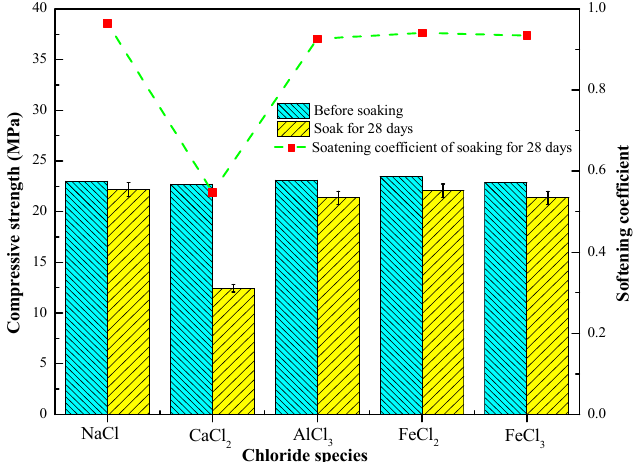
Figure 4. Compressive strength and softening coefficient of hardened pastes of 517 phase immersed in different chloride solutions for 28 days.